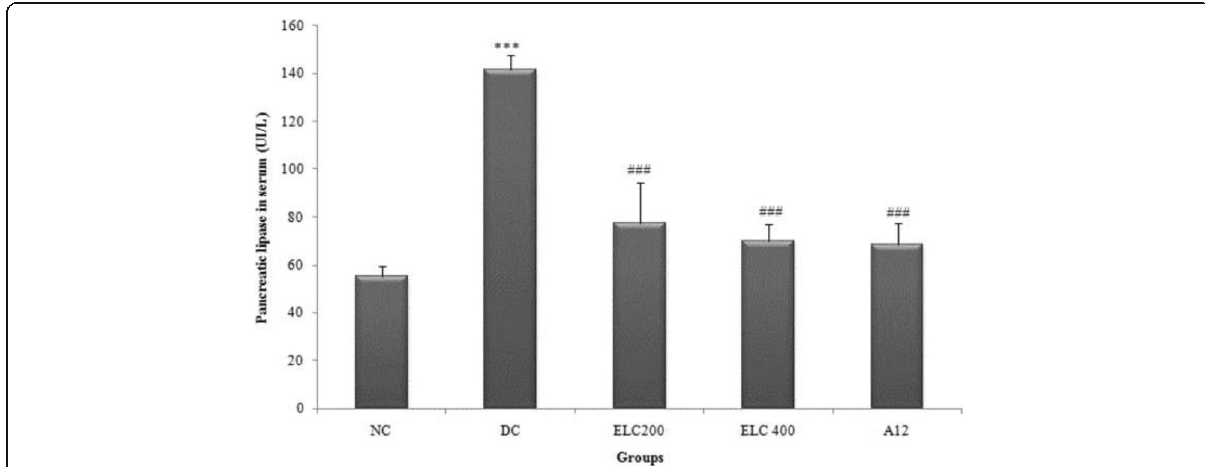
Fig. 6 Levels of lipase pancreatic activity in serum of experimental groups of rats. Normal (NC) and Diabetic control (DC). ELC200&400: Ethanol extract from leaves of C. scolymus at doses of 200 and 400 mg/kg per day; A12: Acarbose at dose of 12 mg/kg per day for 28 days. The values are means ±SD ( n = 8 for each group). *** p ≤ 0.001 was considered significant compared to control group; #### p ≤ 0.001 was considered significant compared to diabetic